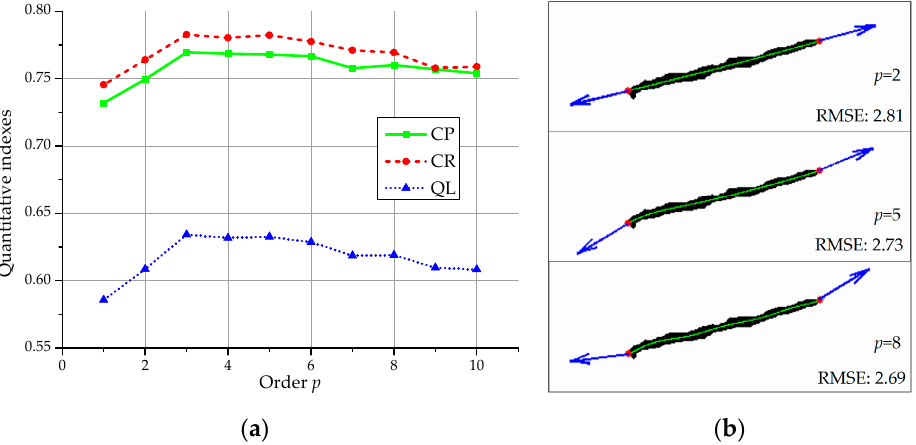
Figure 14. ( a ) The quantitative indexes (completeness, correctness, quality) versus the order p in the